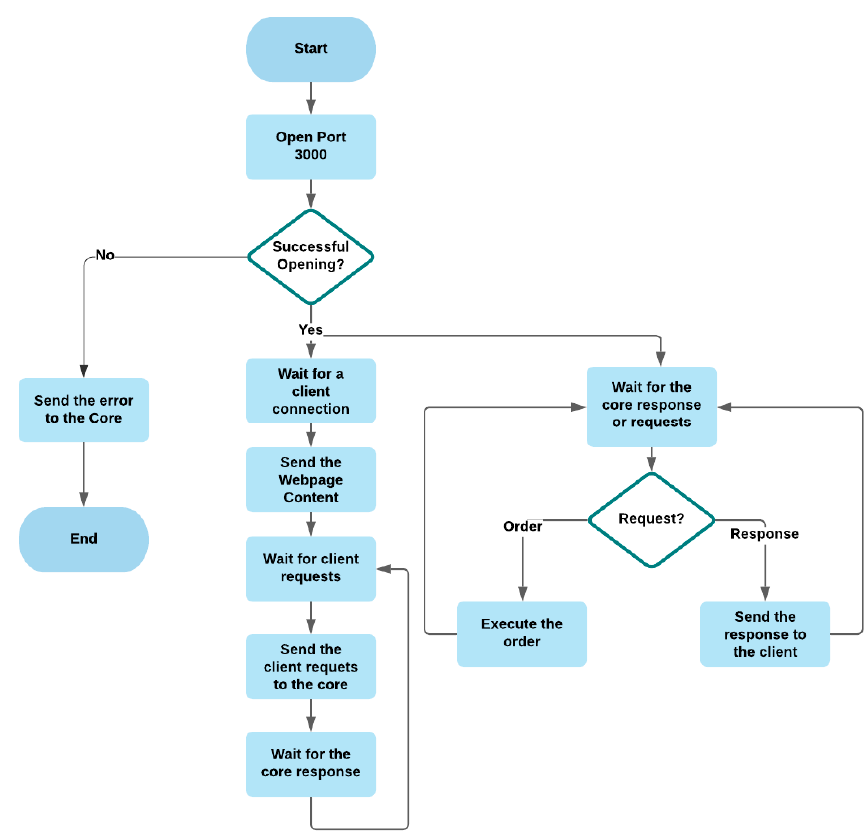
Figure 17. Flowchart of the webserver.